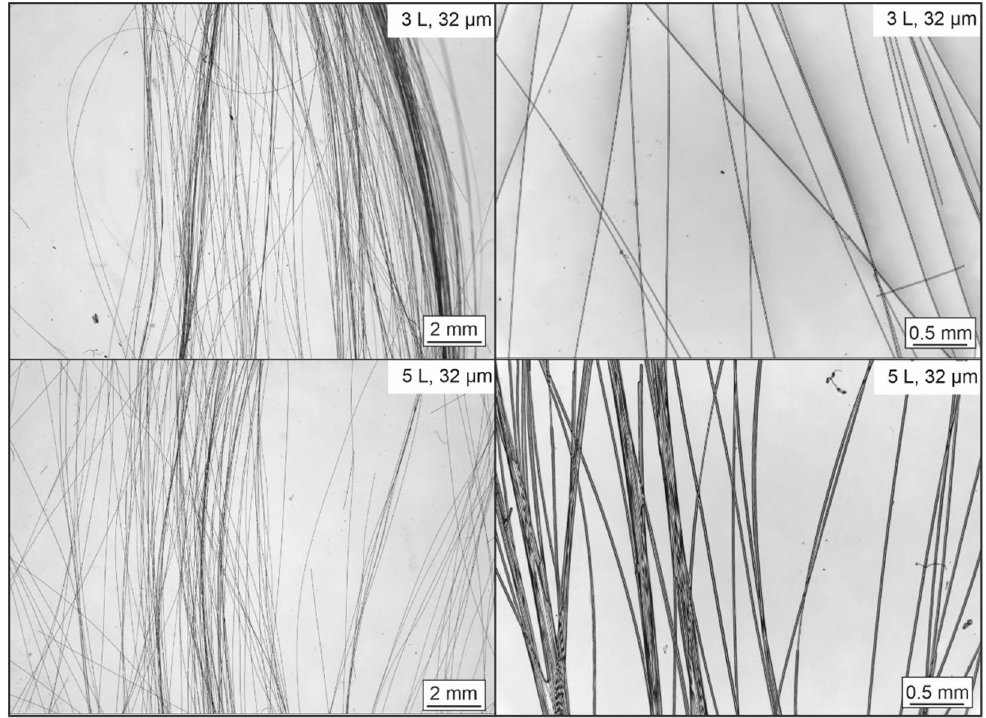
Figure 5. Microscopic image of glass fibers after ultrasonic consolidation, 3-, and 5 layer setups, 32 µm. 32 µ